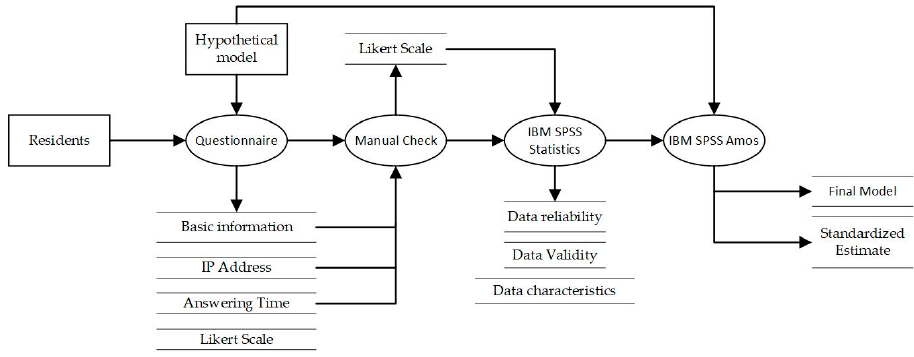
Figure 1. Data flow.